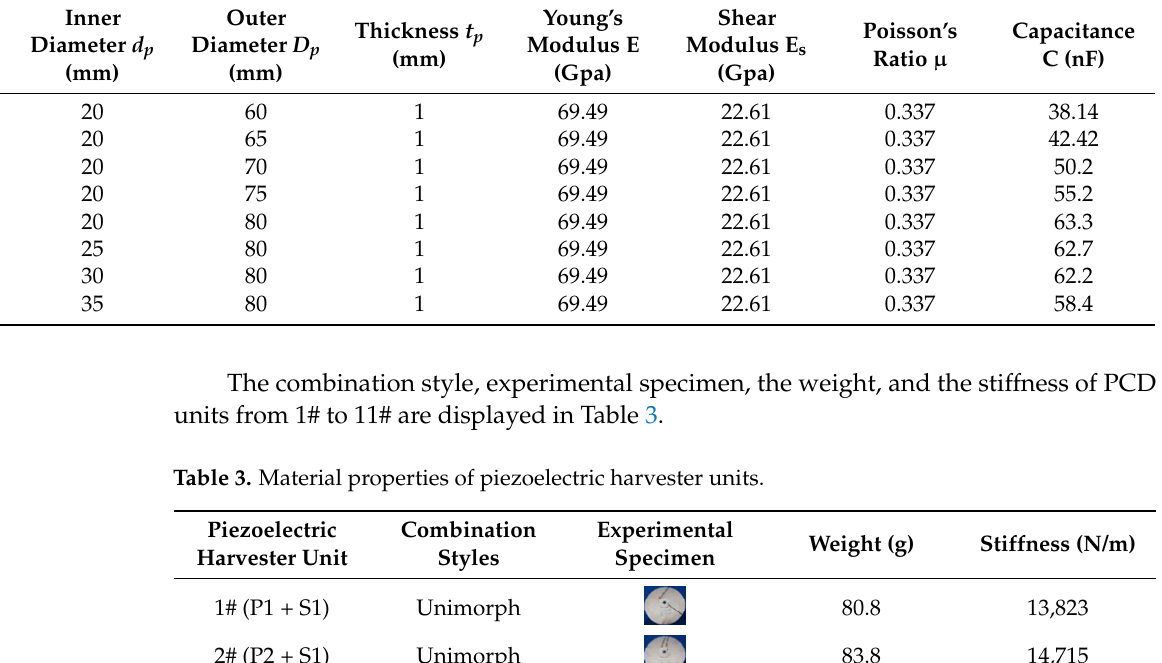
Table 3. Material properties of piezoelectric harvester units.